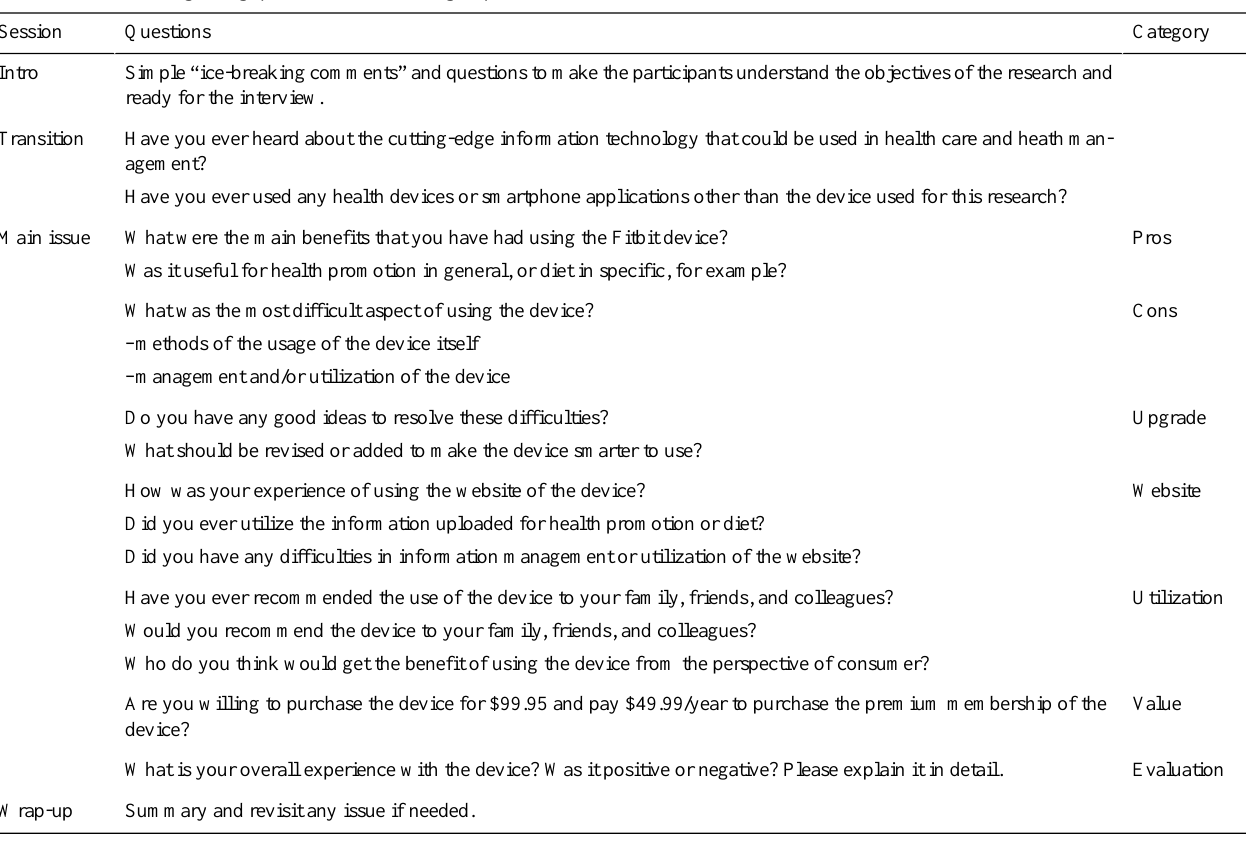
Table 1. Sessions and guiding questions of the focus group